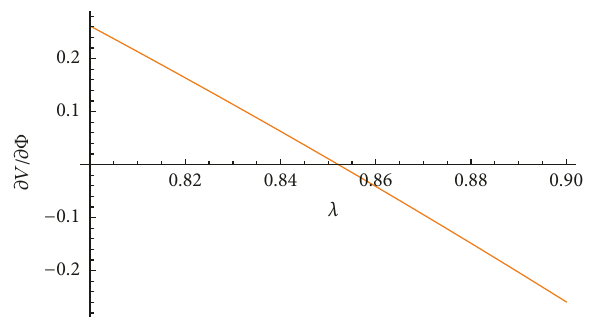
Figure 1: Plot of (𝜕𝑉/𝜕Φ)| Φ= V as function of the parameter 𝜆 in the effective potential